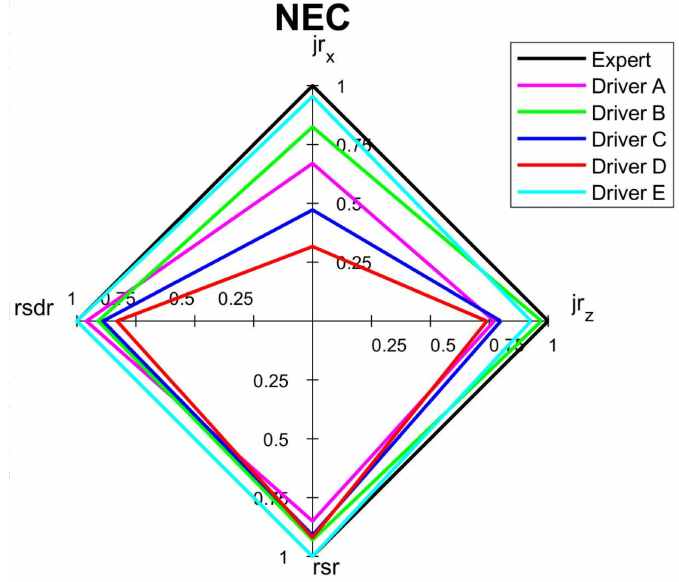
Figure 11. Spider diagram for economy criterion of short